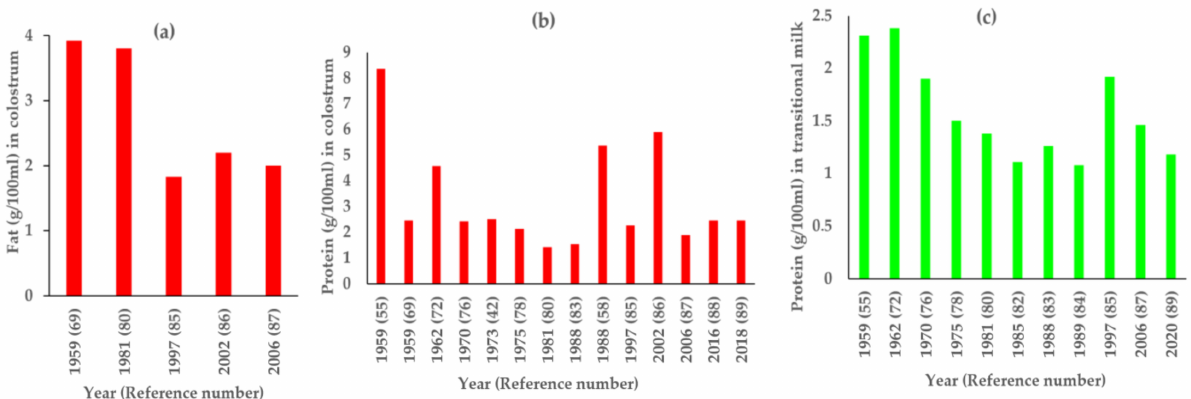
Figure 3. Milk fat and protein (g/100mL) over time ( a ) colostrum fat, ( b ) colostrum protein, and ( c ) transitional